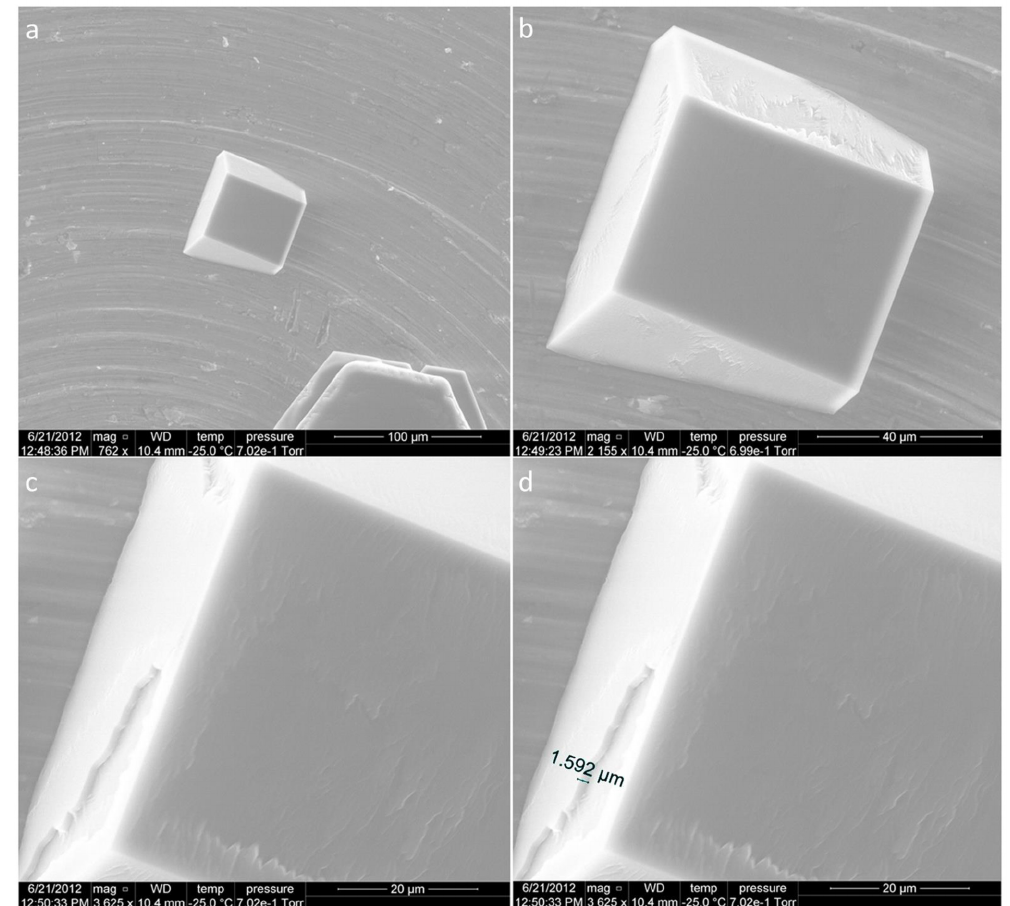
Figure 2. Demonstration of increased magnification effect upon perceived roughness, as well as a measurement of ridge depth (panel d ). Data detail available in Appendix Table